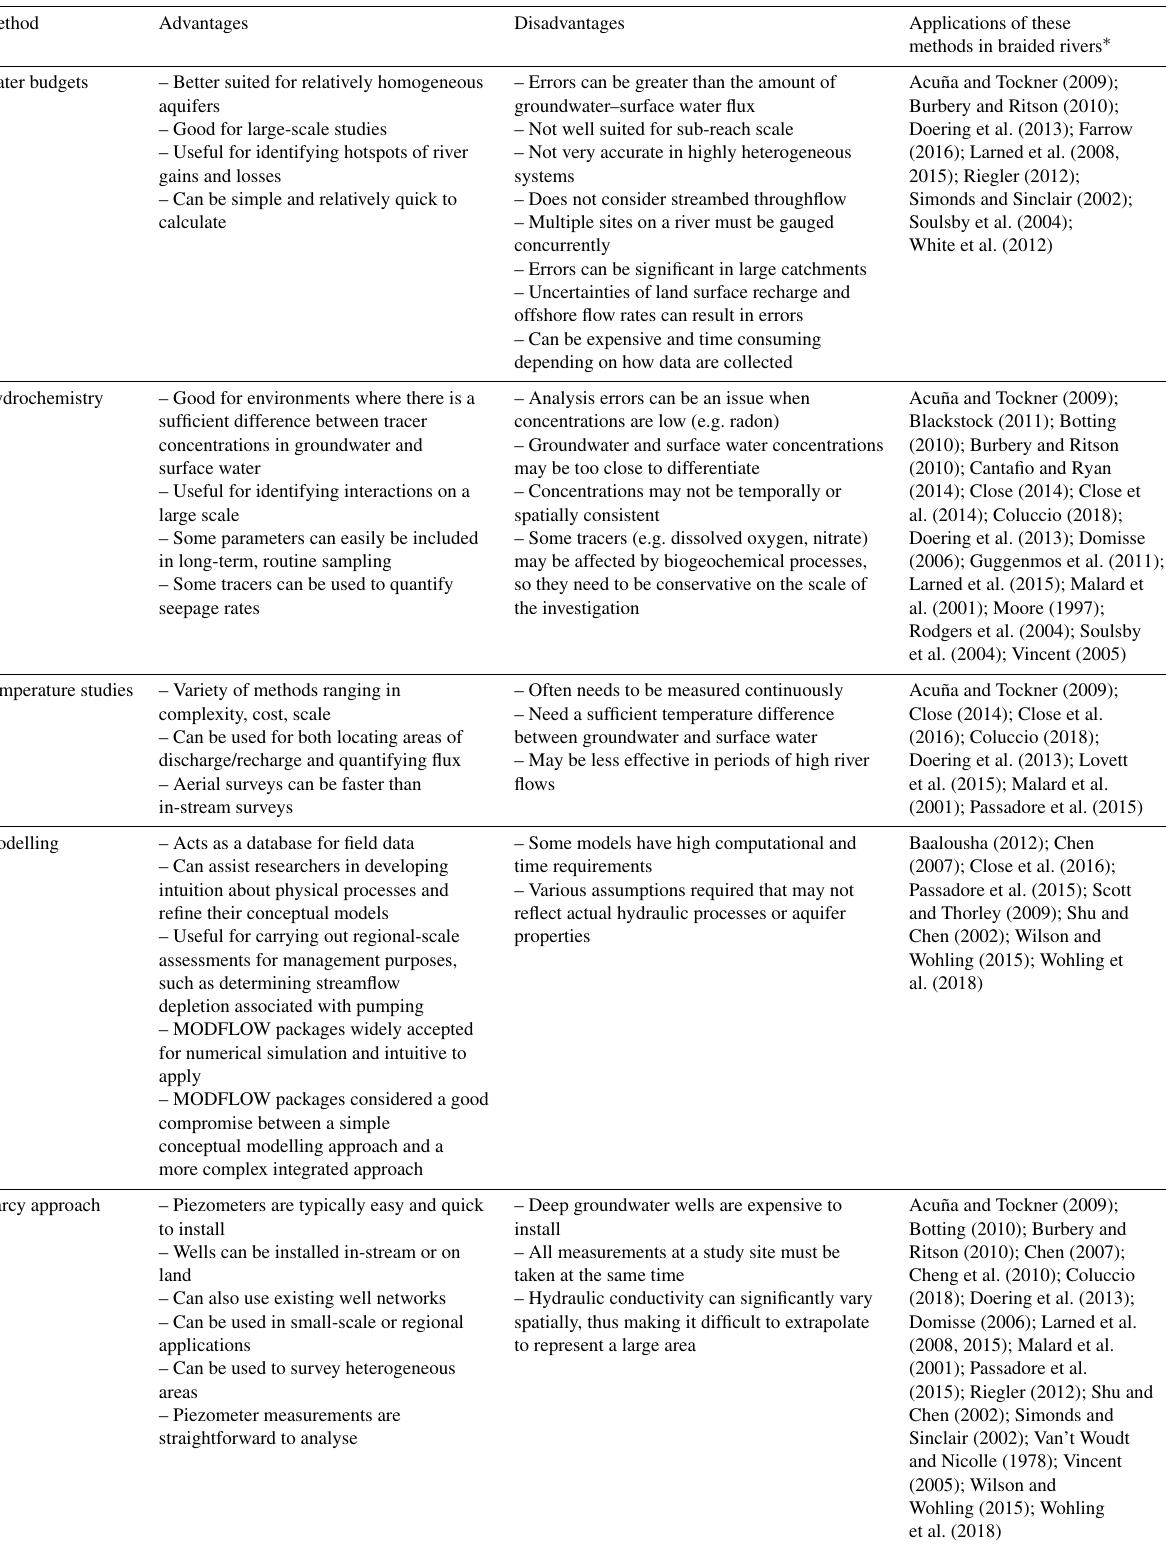
Table 1. Advantages and disadvantages of various methodologies for measuring groundwater–surface water interactions in braided